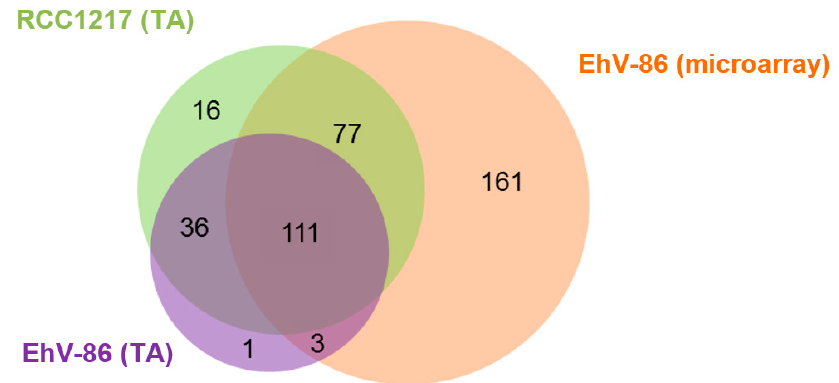
Figure 1. Venn diagram illustrating the comparative Emiliania huxleyi virus (EhV) coding sequence (CDS) expression in different strains and between treatments. In green, RCC1217 (1N) complementary cDNA (cDNA) hybridised onto a CCMP1516 + EhV ‐ 86 tiling array (TA) (this study). In purple CCMP1516 + EhV-86 3.5 h post infection cDNA hybridised onto the TA (this study). In orange, CCMP1516 EhV ‐ 86 cDNA hybridised onto conventional microarrays [10,29].